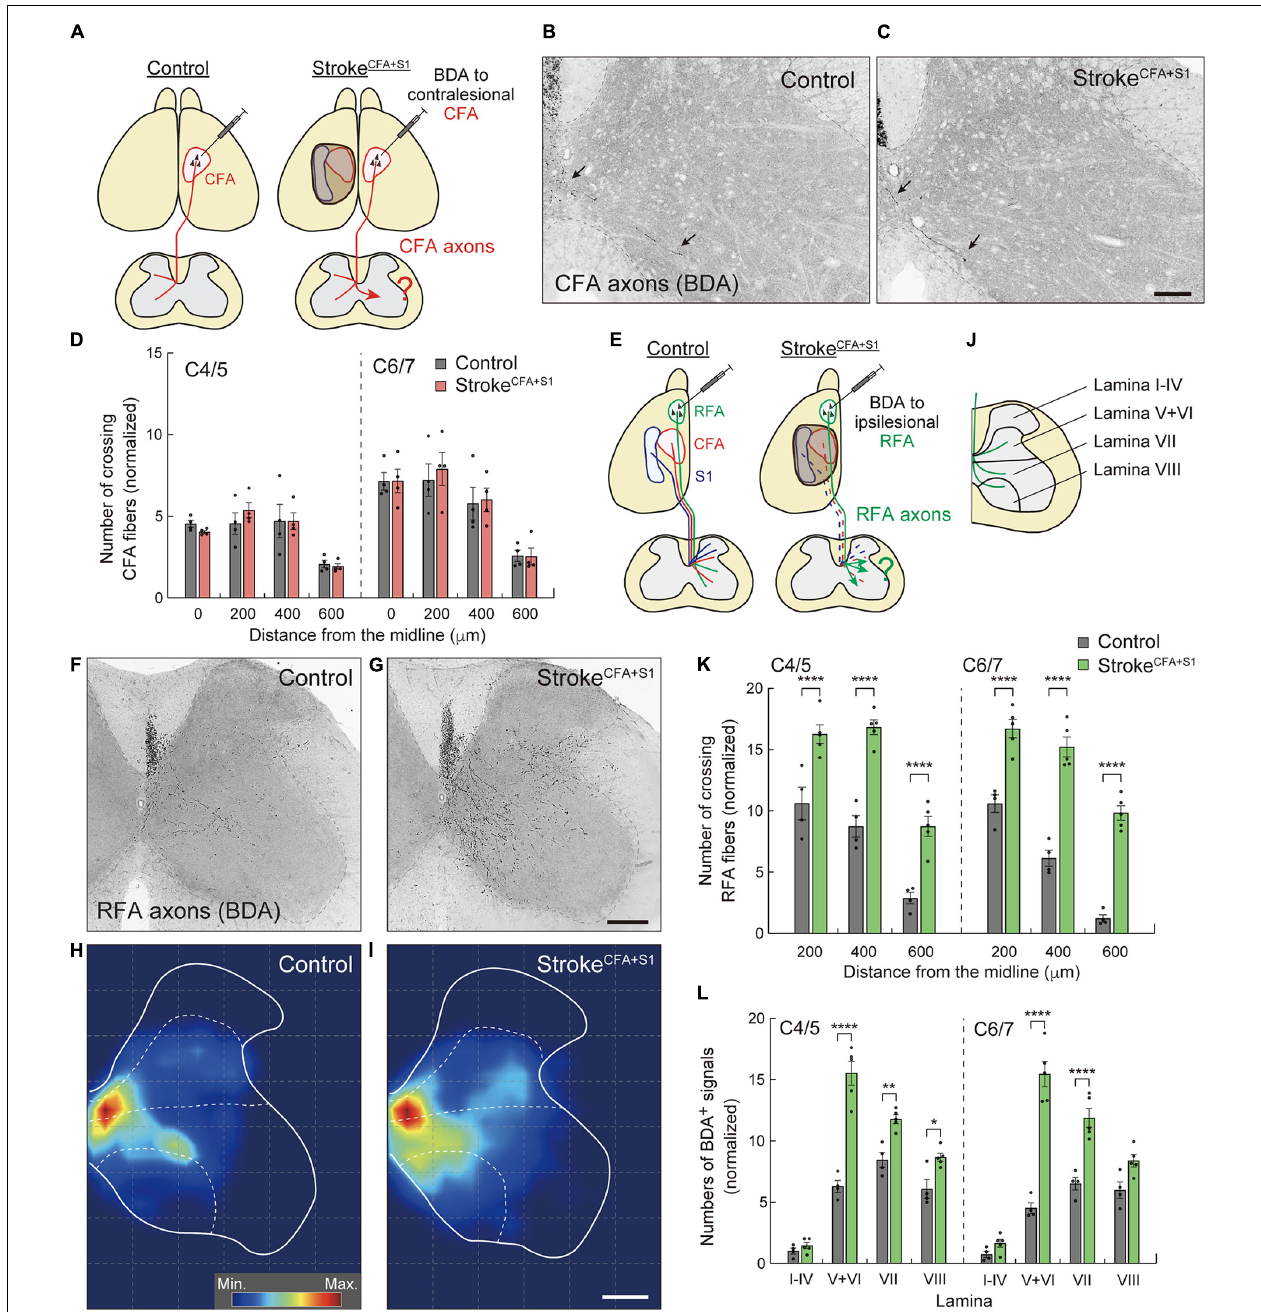
FIGURE 4 | Ipsilesional CST axons of RFA are dominantly rewired after a small cortical stroke in CFA and S1. (A) Experimental diagram of anterograde tracing of CST axons from the contralesional CFA in stroke CFA + S 1 . (B,C) Representative images of BDA-positive axons in the cervical spinal cord (C5) of control (B) and stroke CFA + S 1 animals (C) . Arrows indicate the crossing fibers projecting to the denervated side. (D) Quantitative data of the crossing fibers across the indicated positions in the denervated side of C4–7. F ( 1 , 48 ) = 0.1689, p = 0.6830, two-way ANOVA; p > 0.9999 (all), Bonferroni post hoc test. (E) Diagram of anterograde tracing of CST axons from the ipsilesional RFA. The dotted lines indicate degenerated CST pathways from CFA and S1. (F,G) Representative images of CST projections of ipsilesional RFA at C5 in control (F) and stroke CFA + S 1 animals (G) . (H,I) Distribution heatmaps of the ipsilesional CST axons of RFA in the indicated animals. (J) Illustration of the cervical spinal cord representing the quantified areas of axon density corresponding to laminae I–IV, V + VI, VII, and VIII. (K) The number of crossing fibers across the indicated positions in the denervated side of C4/5 and C6/7. F ( 1 , 42 ) = 290.3, p < 0.0001, two-way ANOVA; p < 0.0001 (all), Bonferroni post hoc test. (L) The density of sprouting CST axons of ipsilesional RFA in each lamina. F ( 1 , 56 ) = 290.3, p < 0.0001, two-way ANOVA; p > 0.9999 (lamina I–IV of C4/5 and C6/7), p < 0.0001 (lamina V–VI of C4/5 and C6/7, lamina VII of C6/7), p = 0.0025 (lamina VII of C4/5), p = 0.0327 (lamina VIII of C4/5), p = 0.0605 (lamina VIII of C6/7), Bonferroni post hoc test. * p < 0.05, ** p < 0.01, **** p < 0.0001, n = 4 ( D , control group in K,L ), n = 5 (stroke group in K,L ). Scale bars: 100 µ m in (B,C) ; 200 µ m in (F–I)